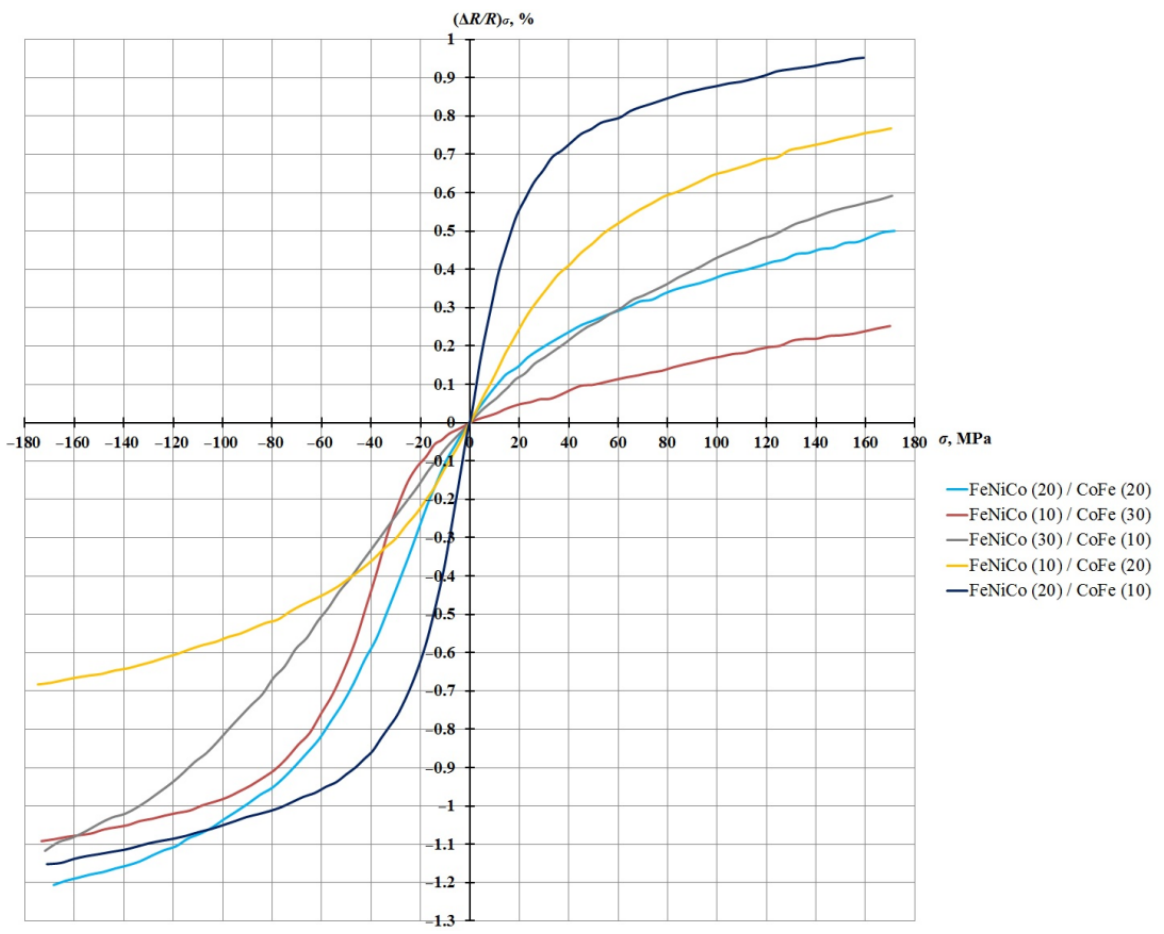
Figure 8. Graph of the dependence of the relative change in resistance due to the load on the mechanical stresses of compression/extension (layer thickness in nm).